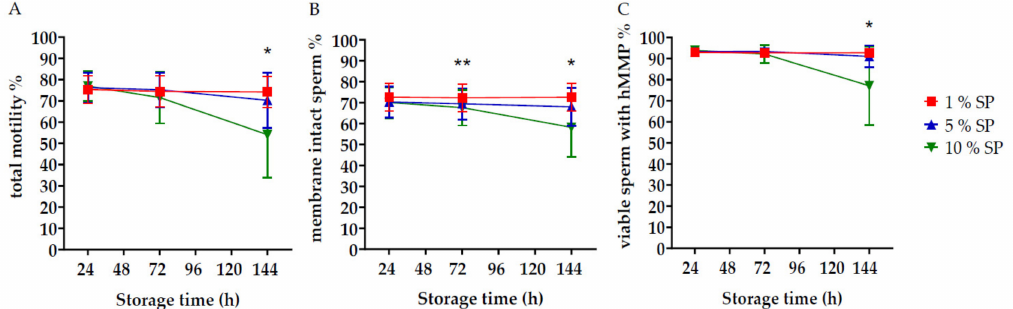
Figure 2. Sperm quality in stored semen doses containing di ff erent concentrations of seminal plasma (SP). Sperm pellets of centrifuged ejaculates ( n = 4–5 from each of 19 boars) were extended with modified Beltsville thawing solution (mBTS) to 18 × 10 6 sperm / mL containing three di ff erent concentrations of SP: 1%, 5% and 10% ( v / v ; final concentration) and semen portions were stored at 17 ◦ C. Graphs present in A ) total motility (%), B ) membrane intact (%; propidium iodide negative and peanut agglutinin (PNA) negative) sperm (%); and C ) viable sperm (%) with high mitochondria membrane potential (hMMP) (propidium iodide-negative sperm with J-aggregates). Values are presented as means and standard deviation ( ± SD). *: 10% SP di ff ers from 5% and 1% SP ( p < 0.05); **: 10% SP di ff ers from 1% SP ( p <